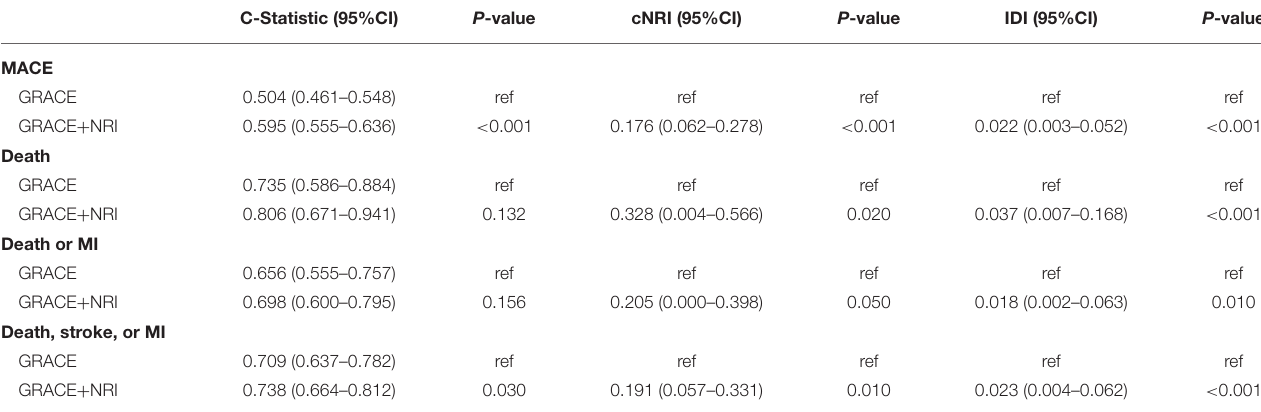
TABLE 6 | Model performance after the addition of NRI to the GRACE score in the diabetes